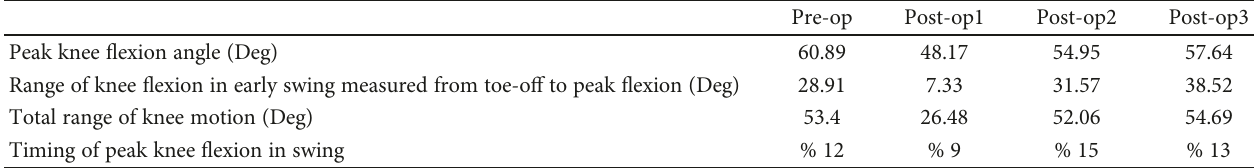
Table 3: Four gait parameters as measures of whether a patient had a sti ff knee gait pattern.